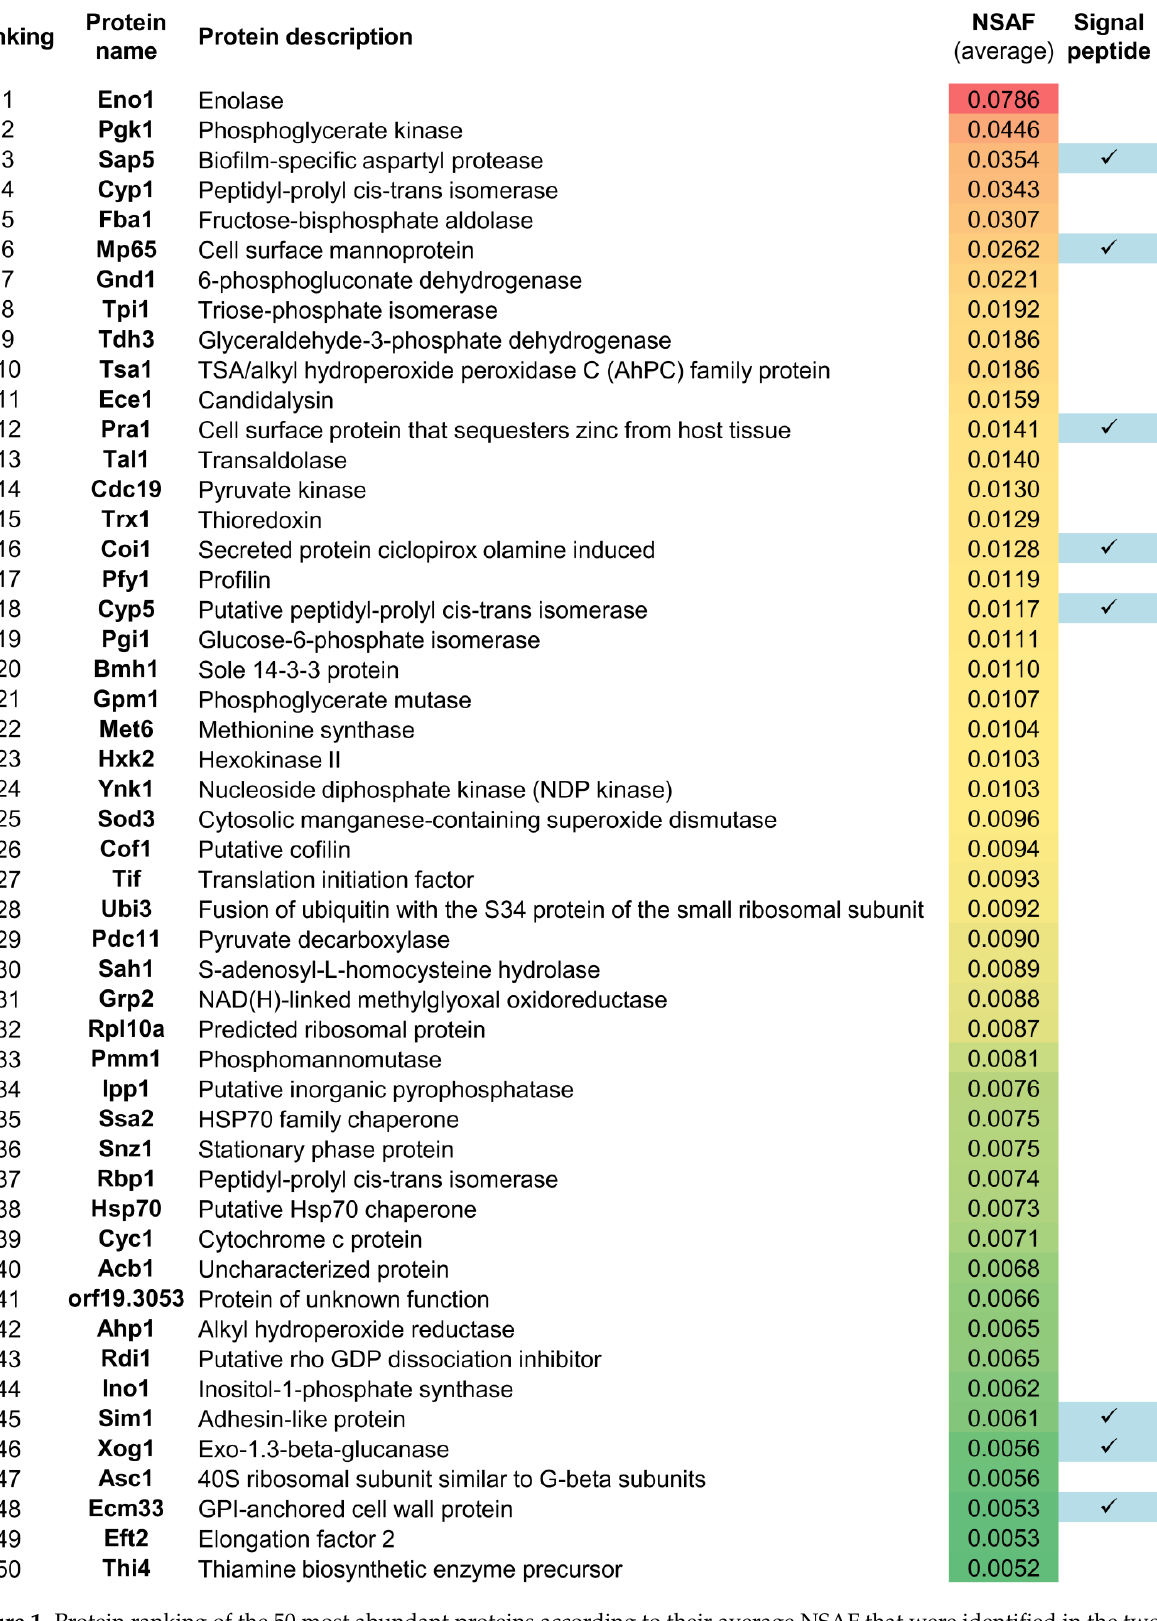
Figure 1. Protein ranking of the 50 most abundant proteins according to their average NSAF that were identified in the two secretome batches (S1 and S2) with at least two peptides by the gel-free LC-MS/MS